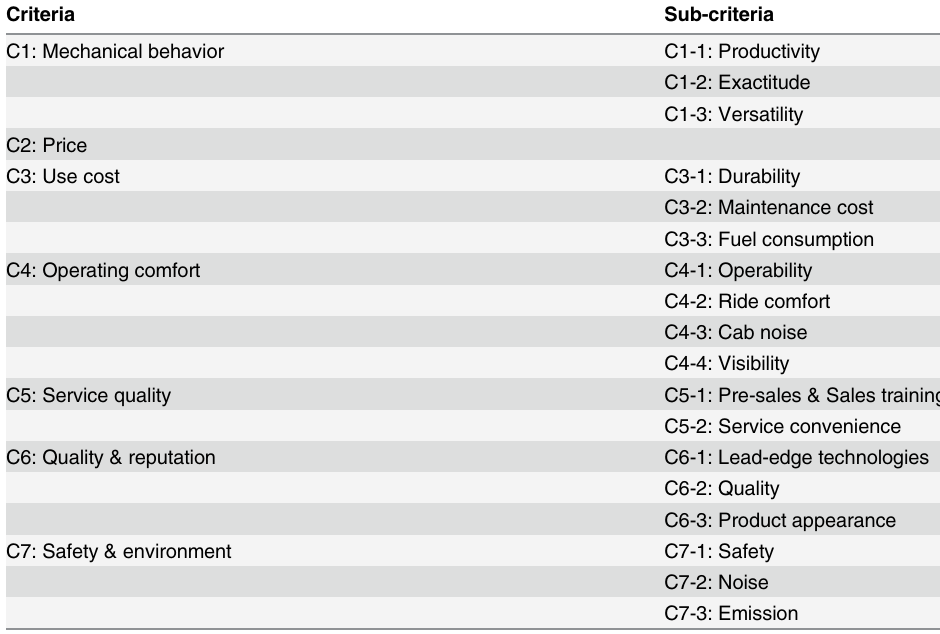
Table 1. Criteria and sub-criteria.